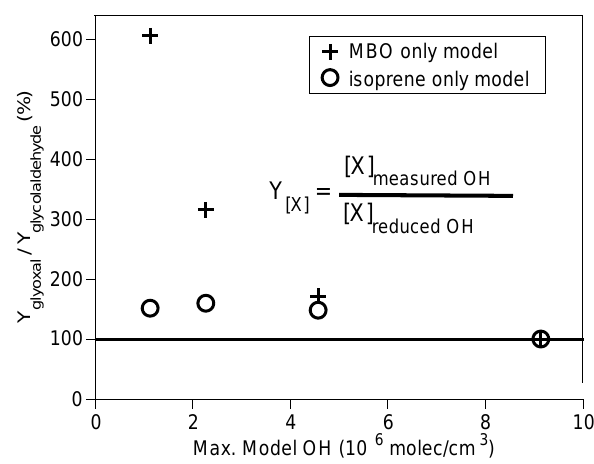
Fig. 8. The ratio of the response function Y of glyoxal for mod- els using either measured OH or reduced OH to the response func- tion Y of glycolaldehyde for the hot period. These results show that for MBO chemistry, glyoxal becomes increasingly more sen- sitive than glycolaldehyde to OH concentration as OH decreases. In isoprene chemistry, glyoxal is always more sensitive than glyco- laldehyde (above 100%) but the magnitude and the trend are less pronounced.